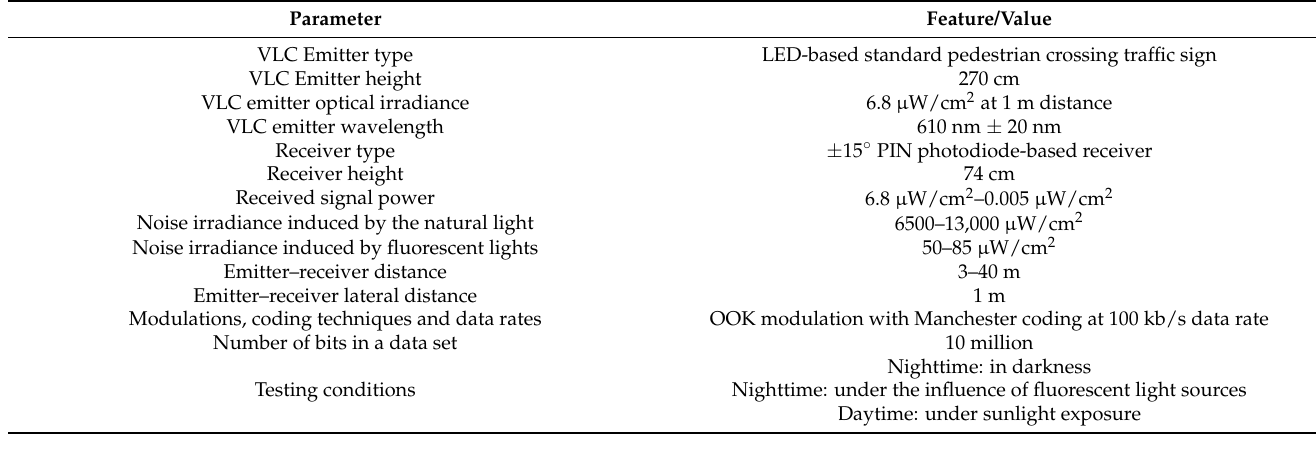
Table 6. Summary of the experimental parameters.